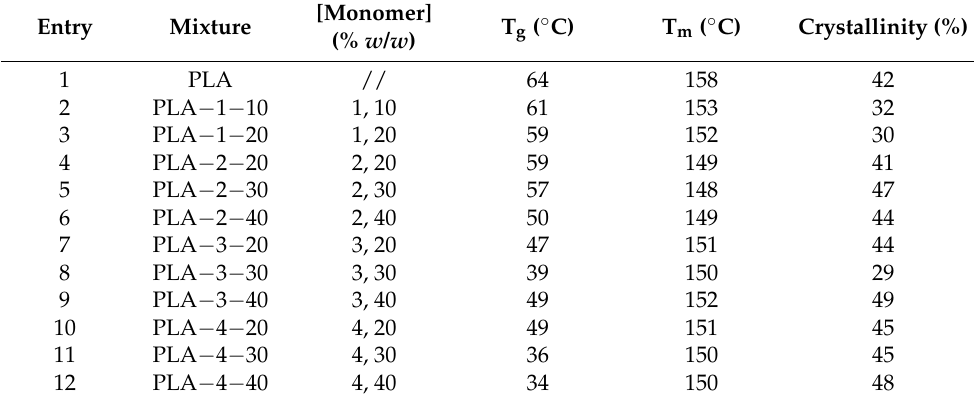
Table 3. Glass transition temperature (T g ), peak melting temperature (T m ), and crystallinity degree corresponding to the different mixtures of PLA/cutin derivatives ( 1 – 4